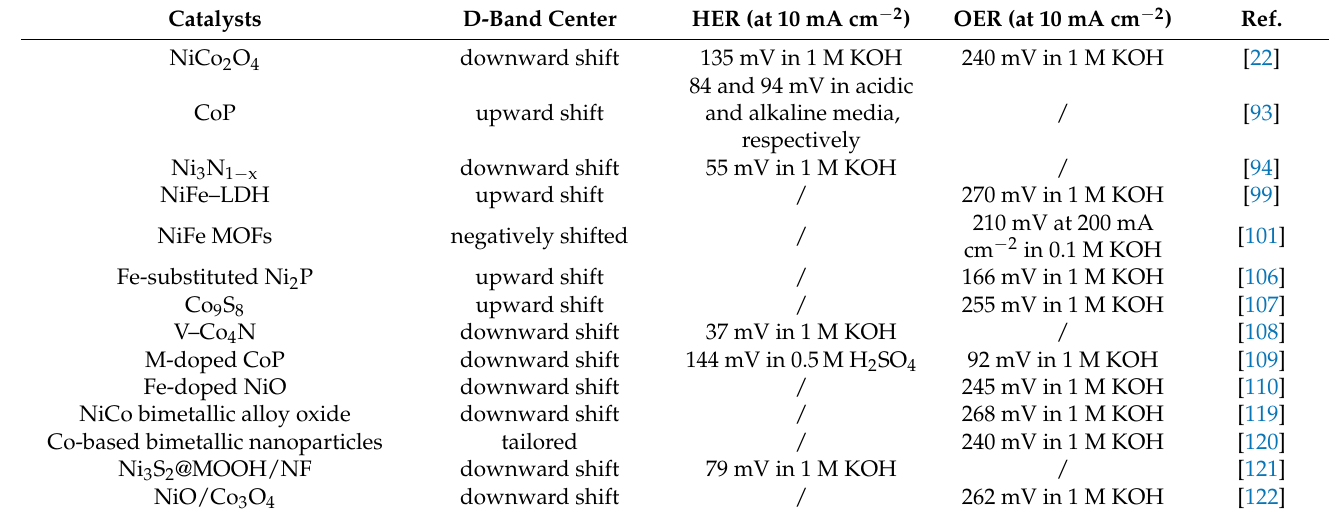
Table 1. Relationships between the d-band center and catalytic performances of catalysts using different regulation